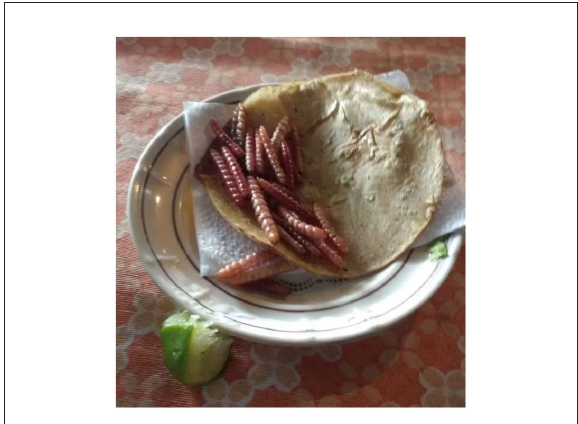
FIGURE3 Red agave worm taco (Comadia redtenbacheri) in Calpulalpan, Tlaxcala, Mexico. Source: Authors own picture.